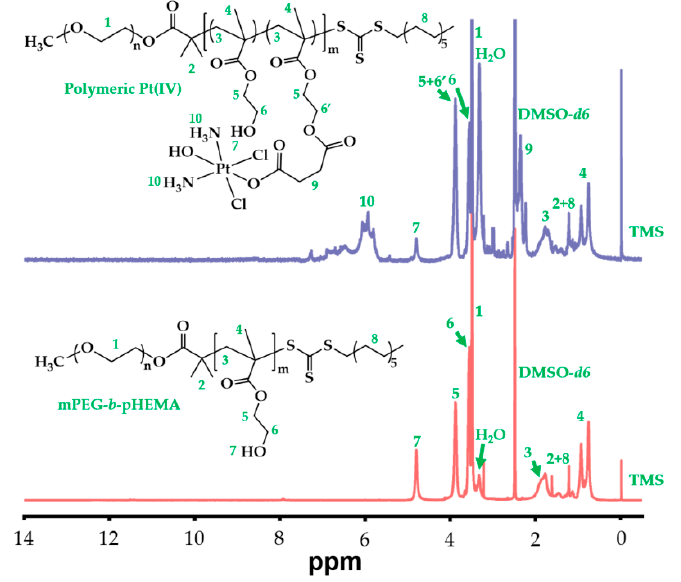
Figure 2. 1 H NMR spectra of mPEG- b -pHEMA and polymeric Pt(IV) in DMSO- d6 .